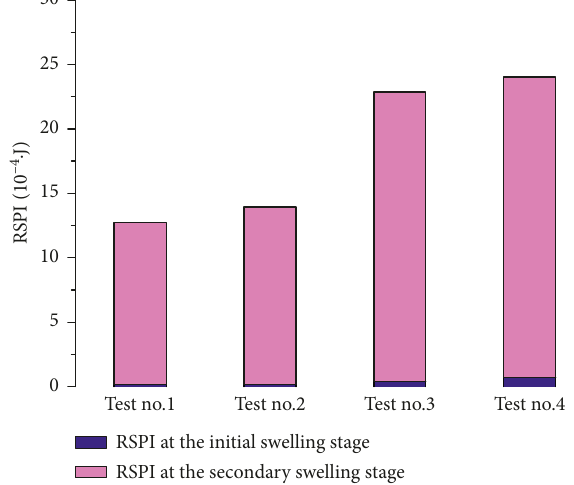
Figure 6: RSPI at different swelling stages.